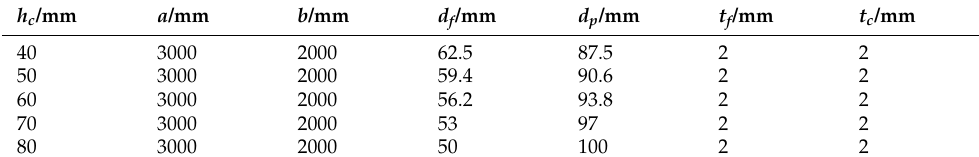
Table 9. Geometric parameters of the Uc ‐ type corrugated sandwich panel with different core heights.